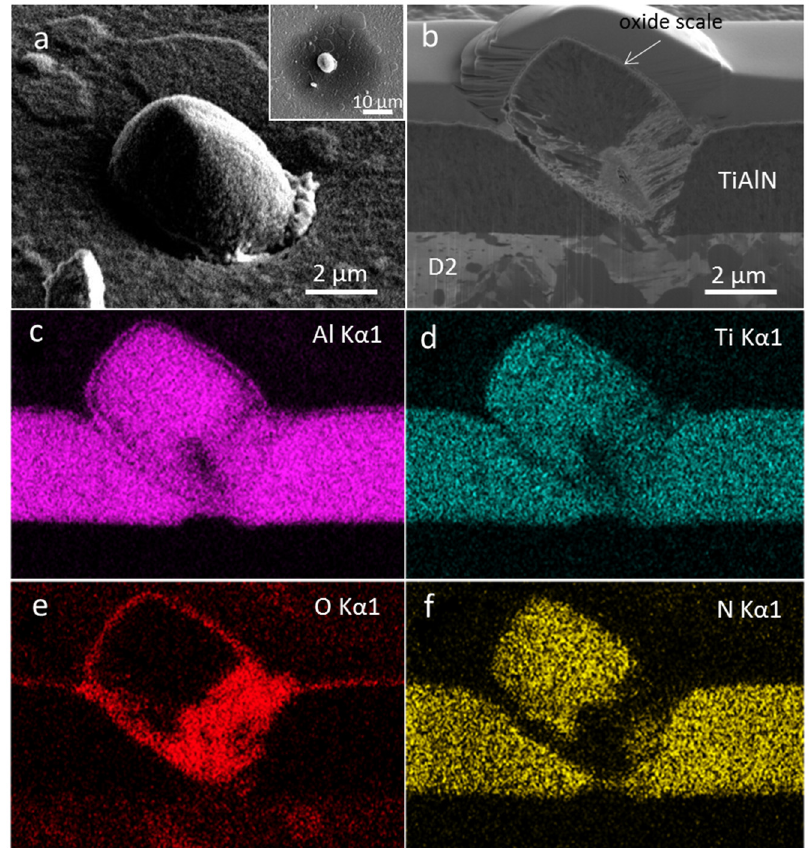
Figure 6. SEM images of nodular defect in sputter-deposited TiAlN hard coating oxidized at 800 °C for 60 min: ( a ) SEM images at high and low (inset) magnification, ( b ) SEM image of the FIB cross-section of the same defect and corresponding elemental maps ( c – f ).